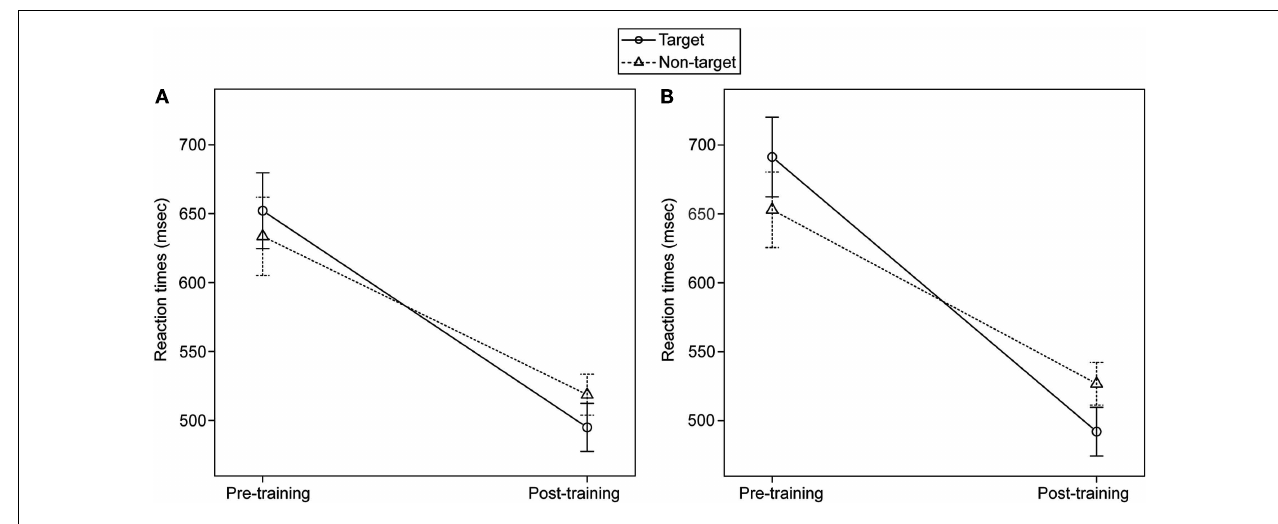
phase (pre, post). (A) Mean RTs for all sentence-picture pairs. (B) Mean RTs in the reduced data set, correcting for the potential bias deriving from the explicit verbal descriptions of the trained manual dexterity tasks given by the